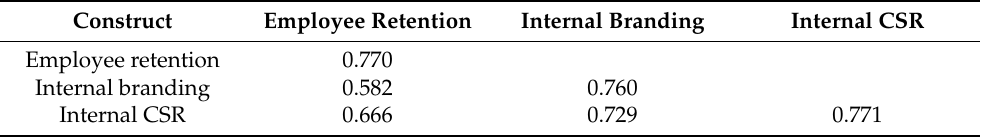
Table 3. Discriminant Validity.